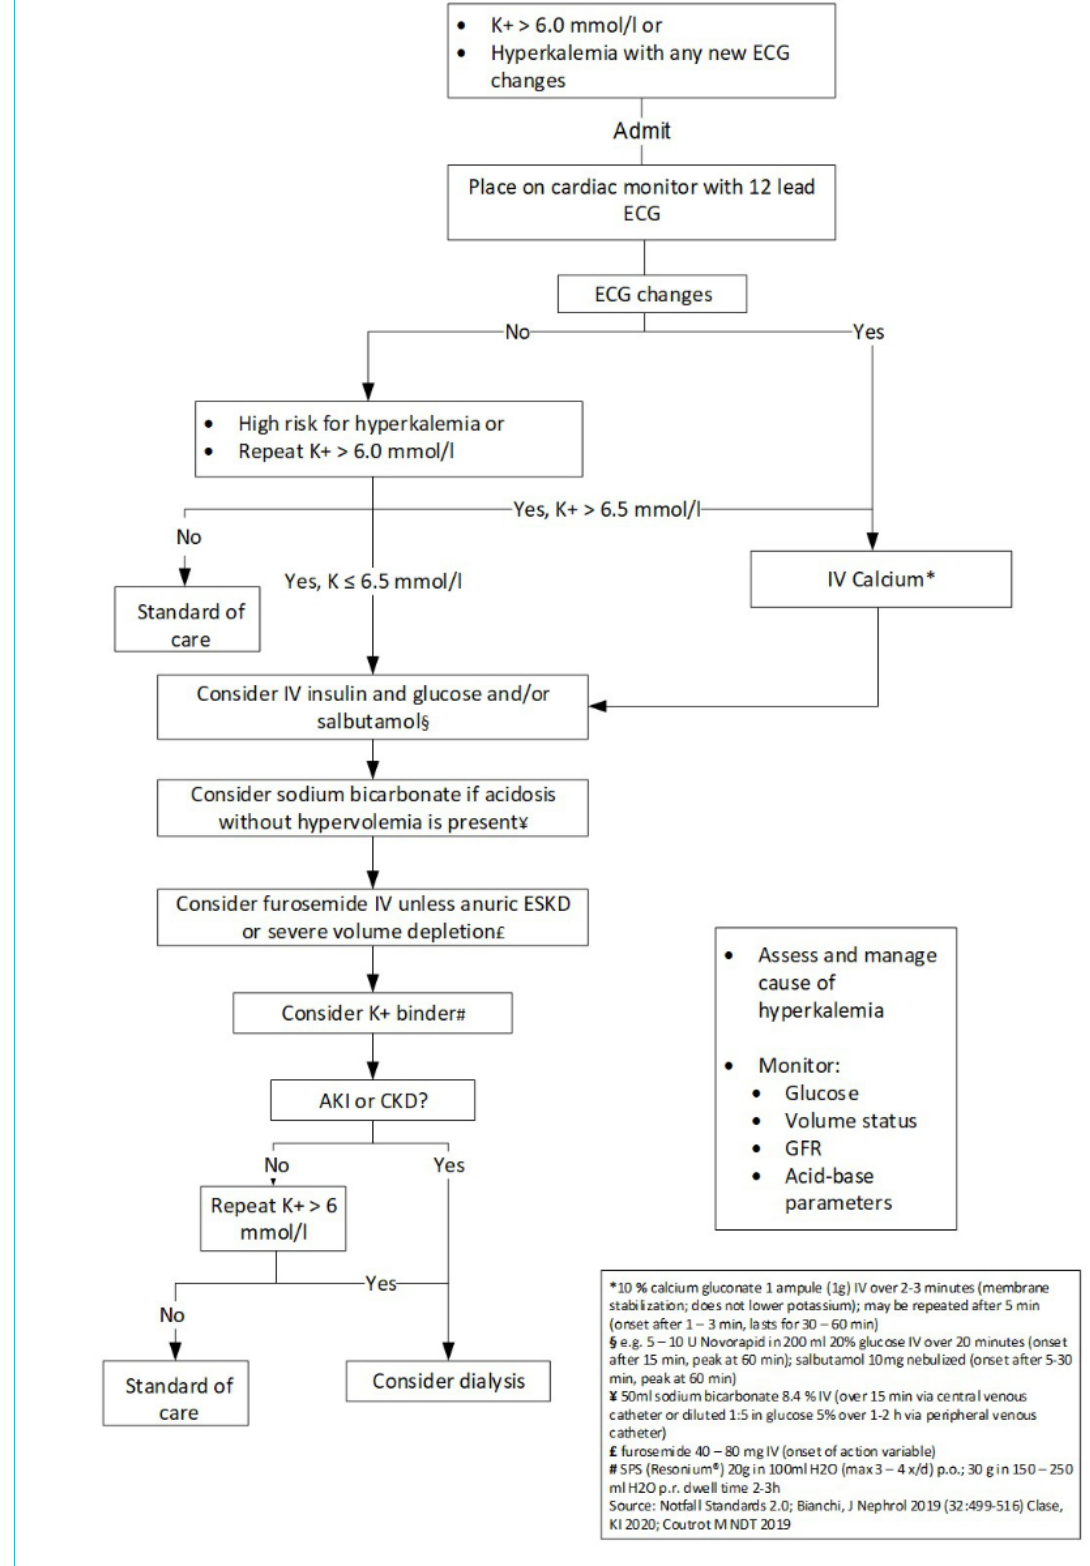
Figure 4: Treatment of acute hyperkalaemia. Suggested management algorithm for acute hyperkalaemia in adult patients (adapted from: Clase CM, et al. Potassium homeostasis and management of dyskalemia in kidney diseases: conclusions from a Kidney Disease: Improving Global Outcomes (KDIGO) Controversies Conference. Kidney Int. 2020;97(1):42–61 [59]). Depending on the patient and the clinical situation, the sequence of procedures may be